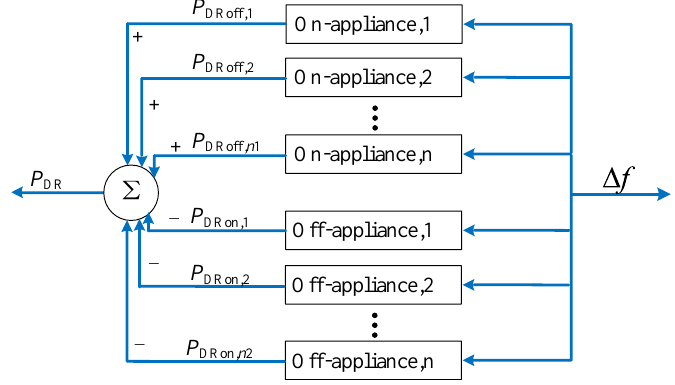
Figure 3. The model of DR resources.